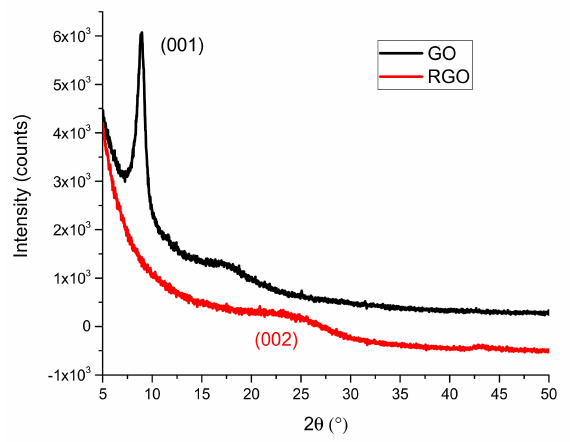
Figure 4. XRD spectra of the GO and RGO